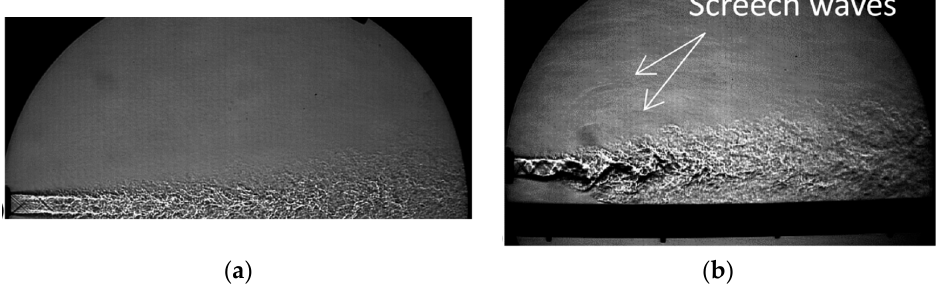
Figure 7. Schlieren images of a jet plane (minor-axis plane). ( a ) Baseline, ( b ) with plate ( h / D = 1). Reproduced from (Ref. [35]), with the permission of the Acoustical Society of America.